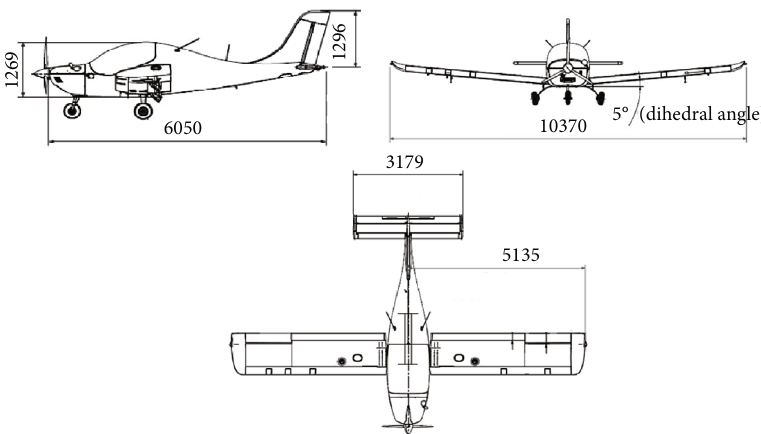
Figure 9: Shape of KLA-100 aircraft (unit: mm). Table 5: Con fi guration data of KLA-100